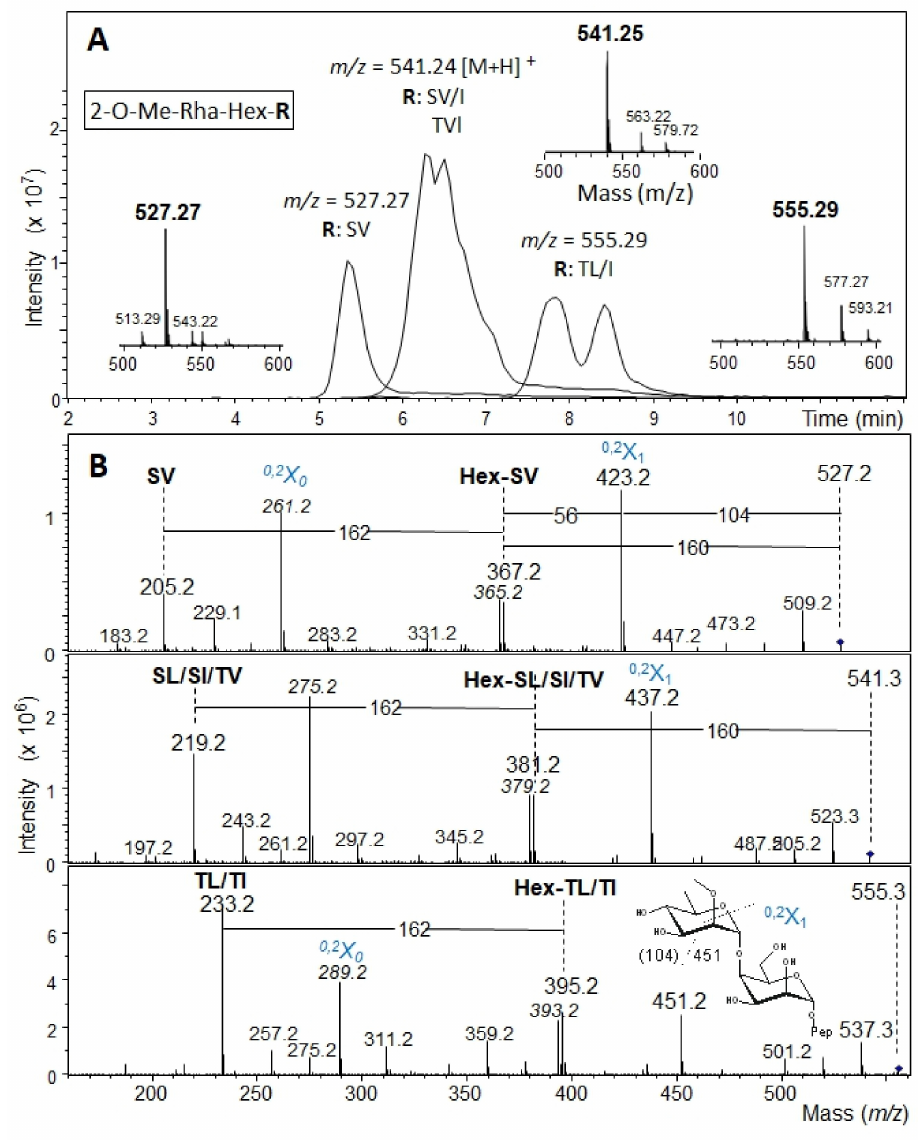
Figure 4. ( A ) Overlaid extracted ion chromatograms of PGC-LC-ESI-MS analysis of B. fragilis ∆ BF4306 glycopeptides obtained by PCG-HPLC fractionation. A mass of 527.27 Da indicates glycopeptide 2-O-Me-Rha-Hex-Ser-Val (fraction f28), of 541.24 Da glycopeptide 2-O-Me-Rha-Hex-Ser-Leu/Ile or 2-O-Me-Rha-Hex-Thr-Val (fraction f32), and of 555.29 Da glycopeptide 2-O-Me-Rha-Hex-The-Leu/Ile (fraction f36). Small insets show the respective MS 1 spectrum. ( B ) The corresponding MS 2 spectra confirm the glycopeptide nature of B. fragilis ∆ BF4306 glycopeptides f28, f32, and f36 as obtained by PGC-HPLC separation and fractionation in the previous purification. The spectra exhibit prominent peaks from cross-ring cleavages. Peaks explicable by rearrangements—as frequently observed in positive mode fragment spectra—are labeled with italic numbers. Cross-ring fragments indicated in blue are described as proposed by Domon and Costello